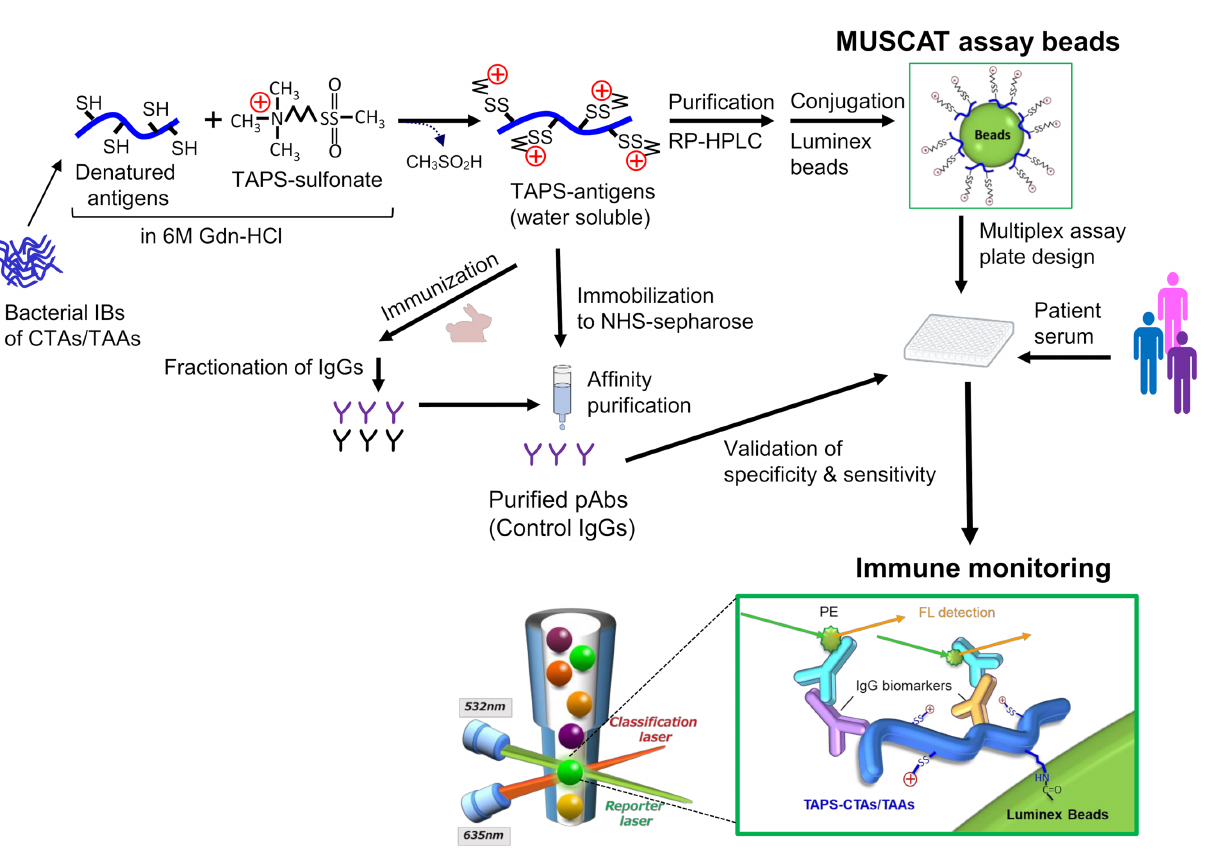
FIGURE 3 | Schematic presentation of antigen engineering of CTAs/TAAs based on solubilization of denatured proteins by S -cationization techniques. Water-soluble and full-length TAPS-antigens were employed to capture speci fi c antibodies for immune monitoring and immunization antigens to develop the control